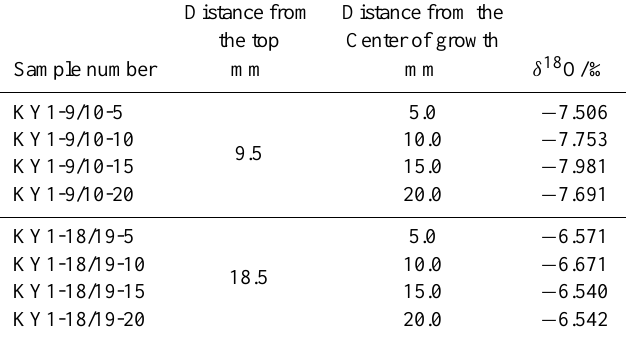
Table 2. The results of the Hendy tests conducted along two growth laminae of ky1 at depths of 9.5 and 18.5mm individually, which indicate that calcite in ky1 was deposited under isotopic equilibrium conditions according to the Hendy test rules (Hendy, 1971). Distance from Distance from the the top Center of